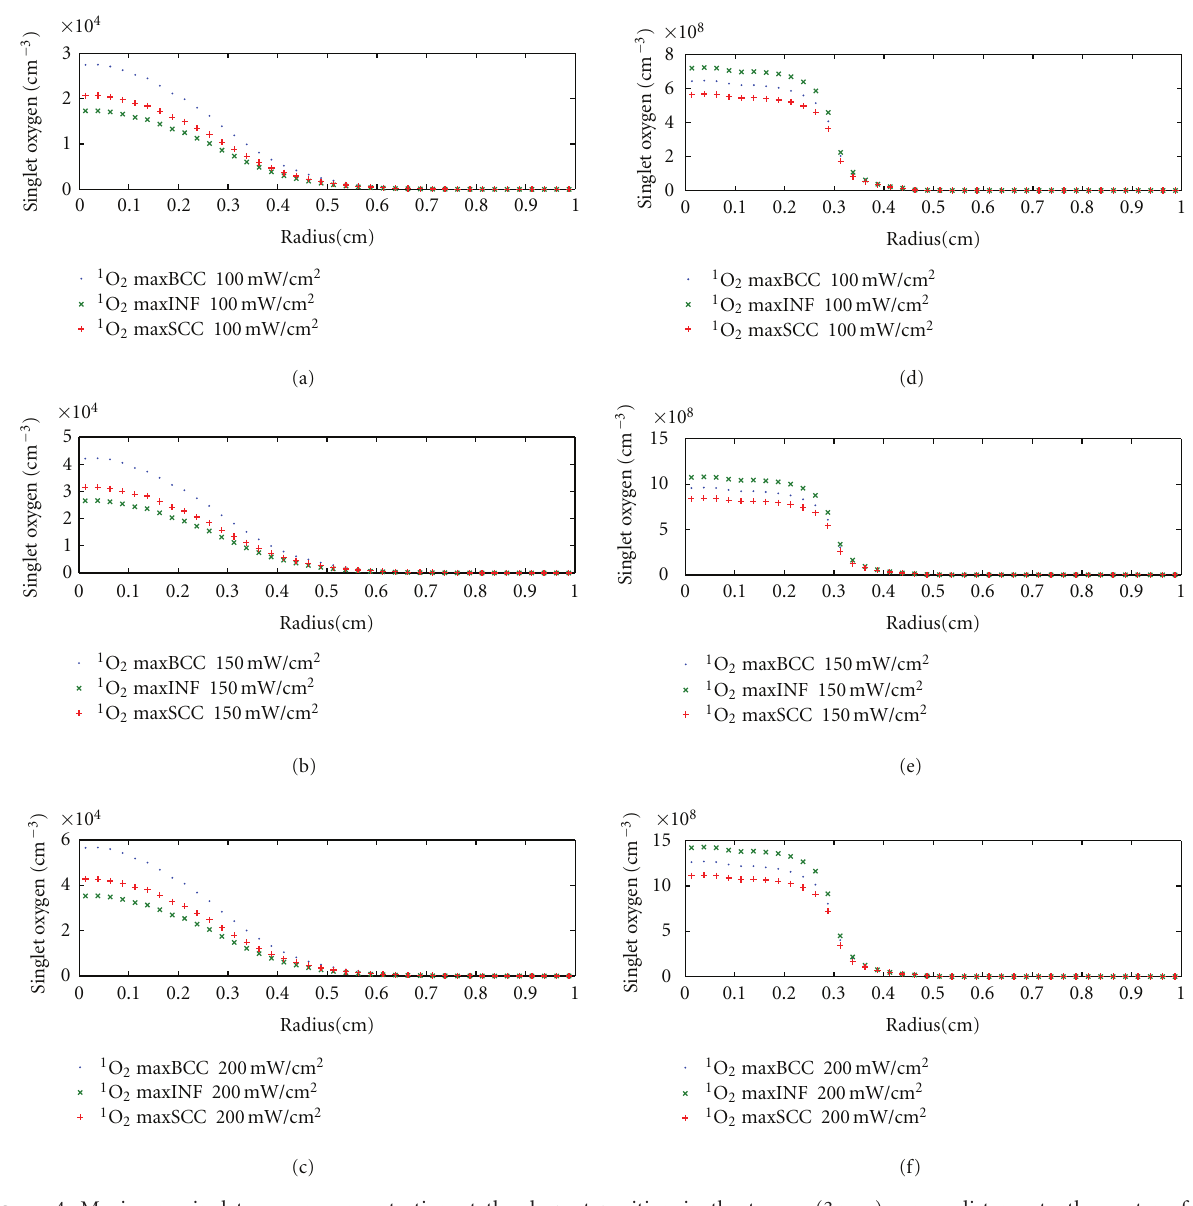
Figure 4: Maximum singlet oxygen concentration at the deepest position in the tumor (3mm) versus distance to the center of the illumination spot for di ff erent irradiances: (a) 100 W/cm 2 , (b) 150 W/cm 2 , and (c) 200W/cm 2 in all the pathologies (BCC: nodular basal cell carcinoma; INF: infiltrative basal cell carcinoma; SCC: squamous cell carcinoma) and at 0.1 mm from the pathology surface and di ff erent irradiances: (d) 100W/cm 2 , (e) 150 W/cm 2 , and (f) 200W/cm 2 .